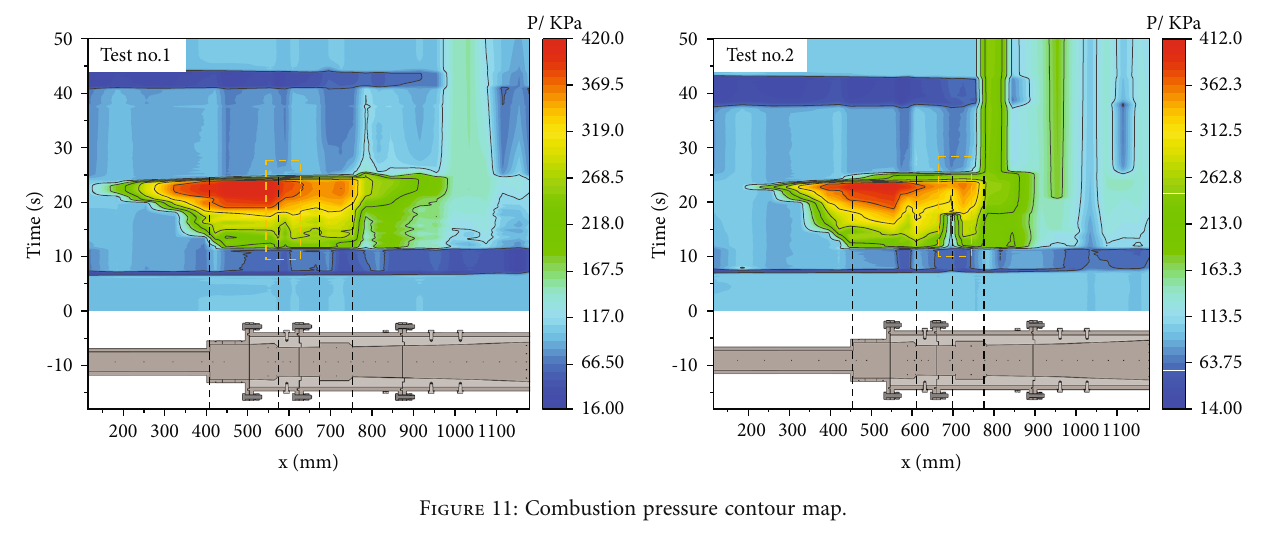
Figure 11: Combustion pressure contour map.